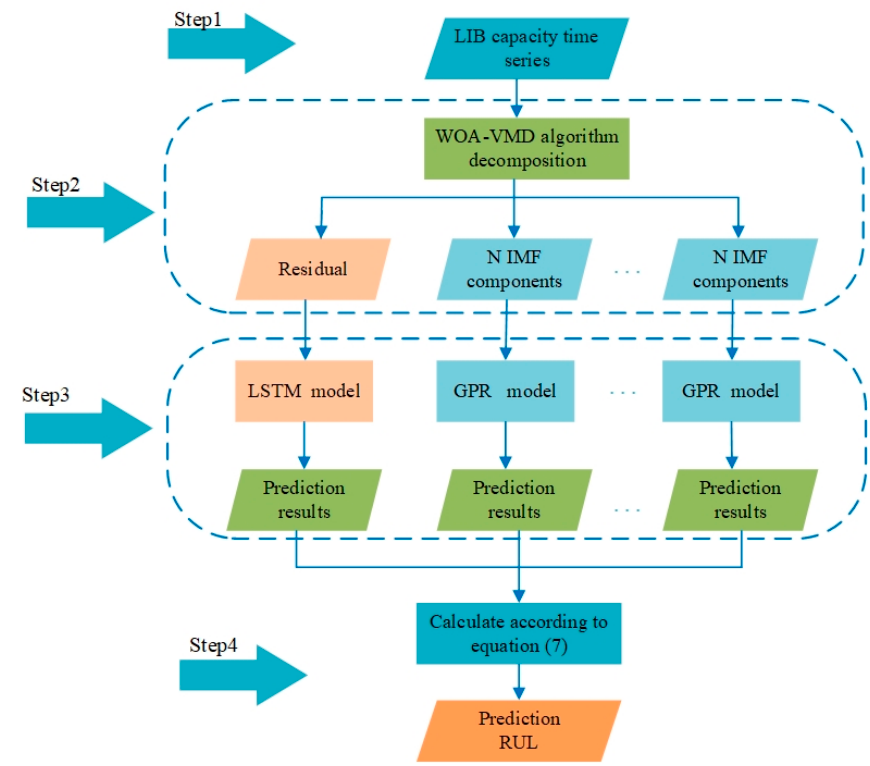
Figure 2. Prediction procedure of battery